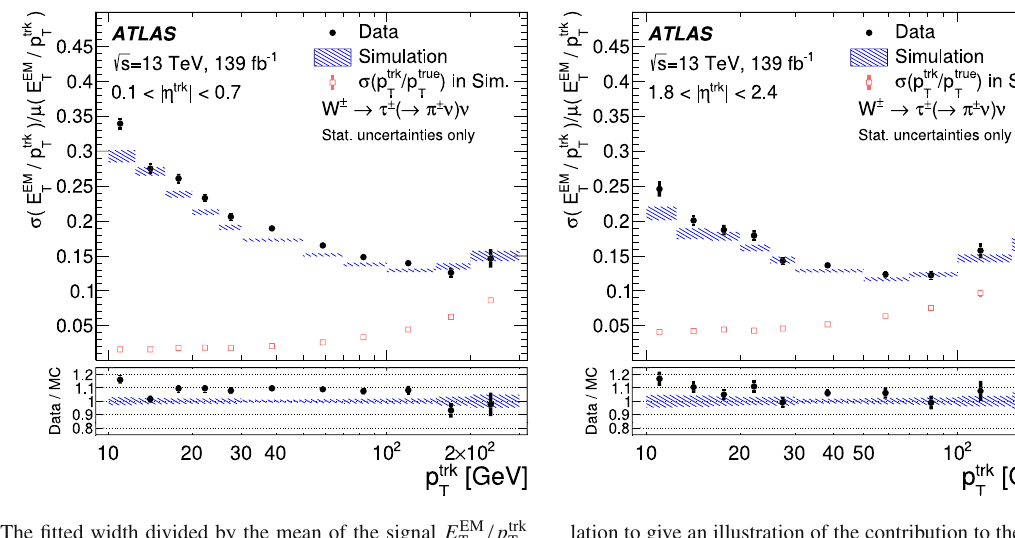
Fig. 8 The fitted width divided by the mean of the signal E EM distribution as a function of the track p T in the central region (left) and endcap region (right). Also shown is the fitted width of the track p T divided by the generator-level p T for true τ → π ± ν τ events in simu-